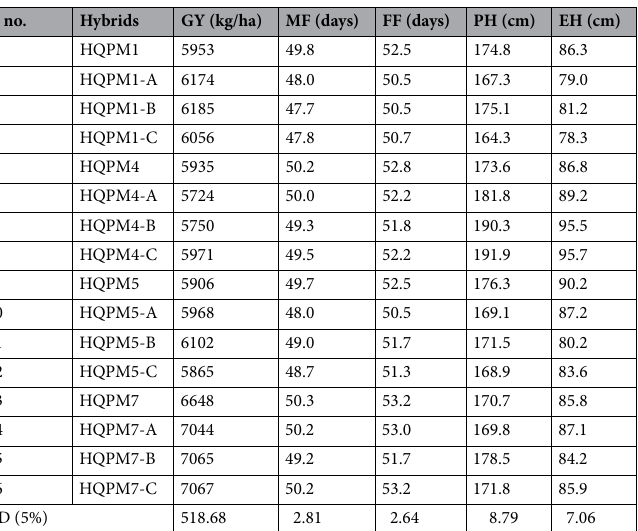
Table 6. Morphological characterization of reconstituted and original hybrids across locations. GY Grain yield, MF days to anthesis, FF days to silking, PH plant height, EH ear height, A-, B-, C-: